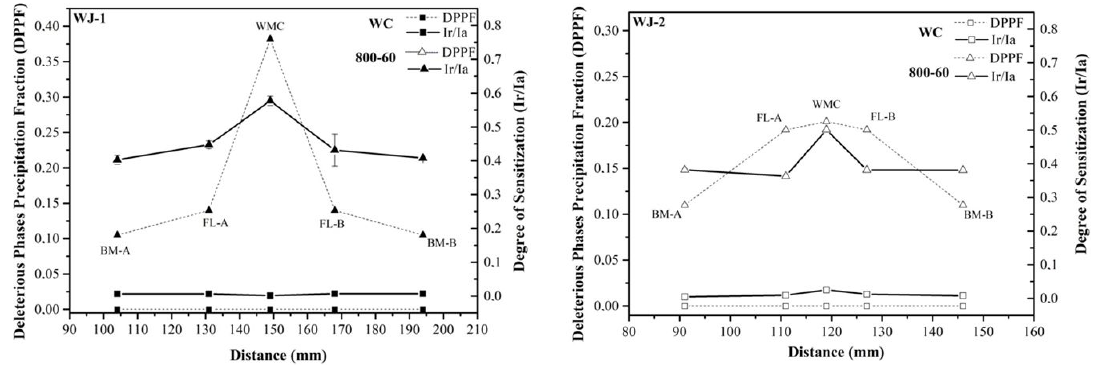
Figure 14. DOS (Ir/Ia ratio) and deleterious phases volume fraction as a function of the analyzed region for the WJ2-60 sample.